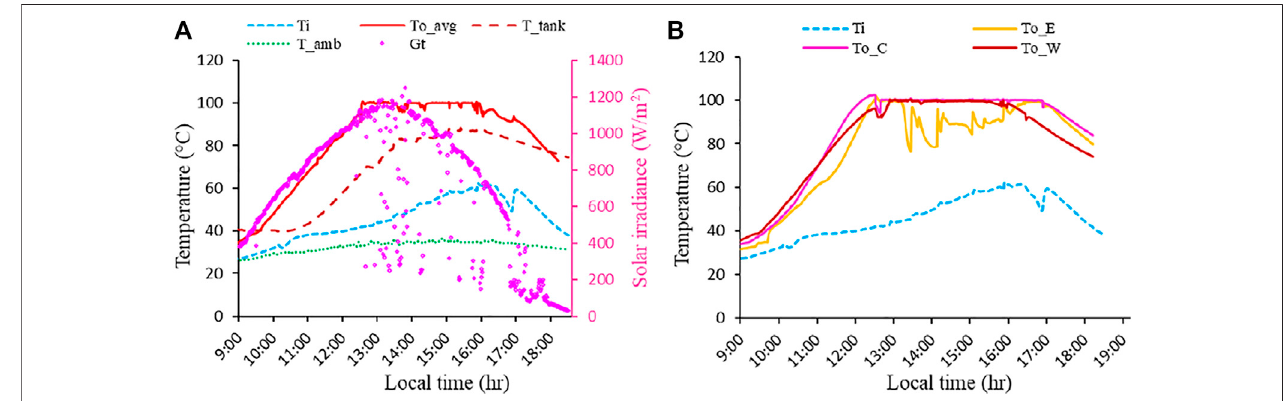
FIGURE 12 | Comparison of the experimental thermal ef fi ciency with a previously developed model ef fi ciency.